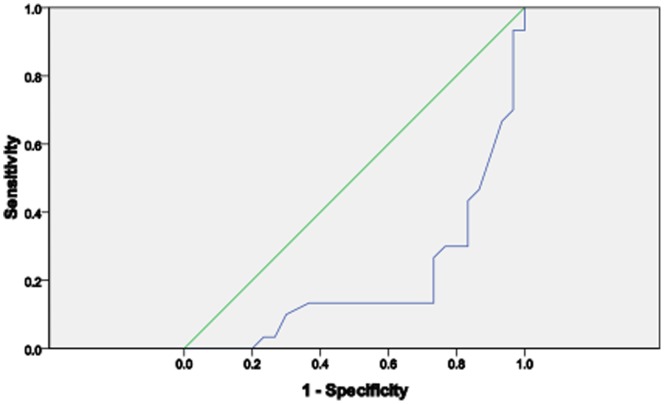
The ROC curve of cortisol in SCA subjects.